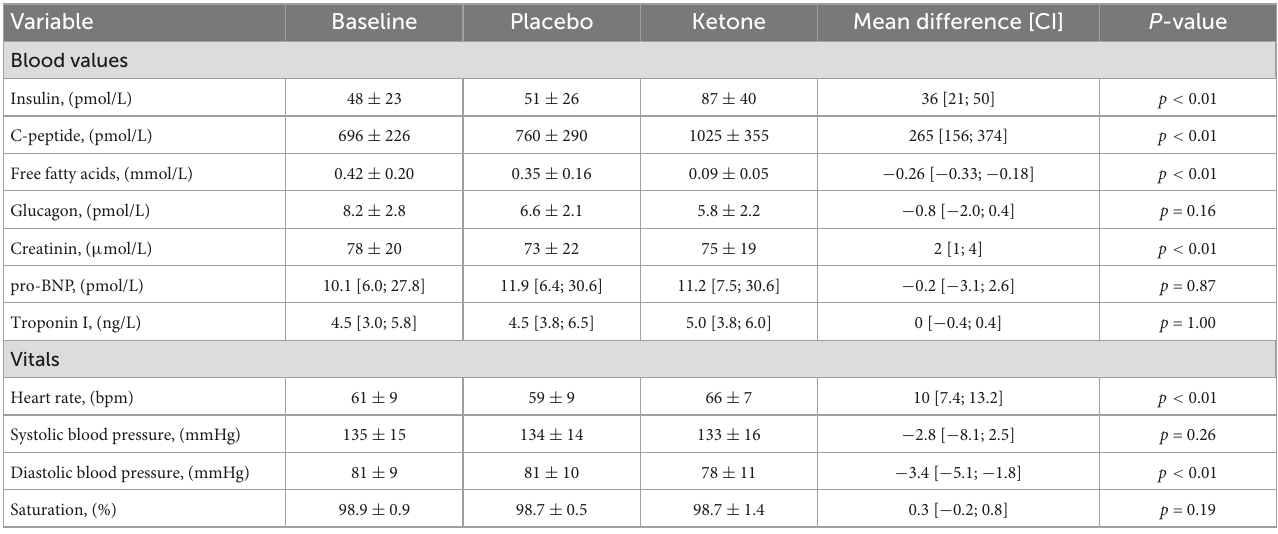
TABLE 3 Effect of ketone esters on blood values and